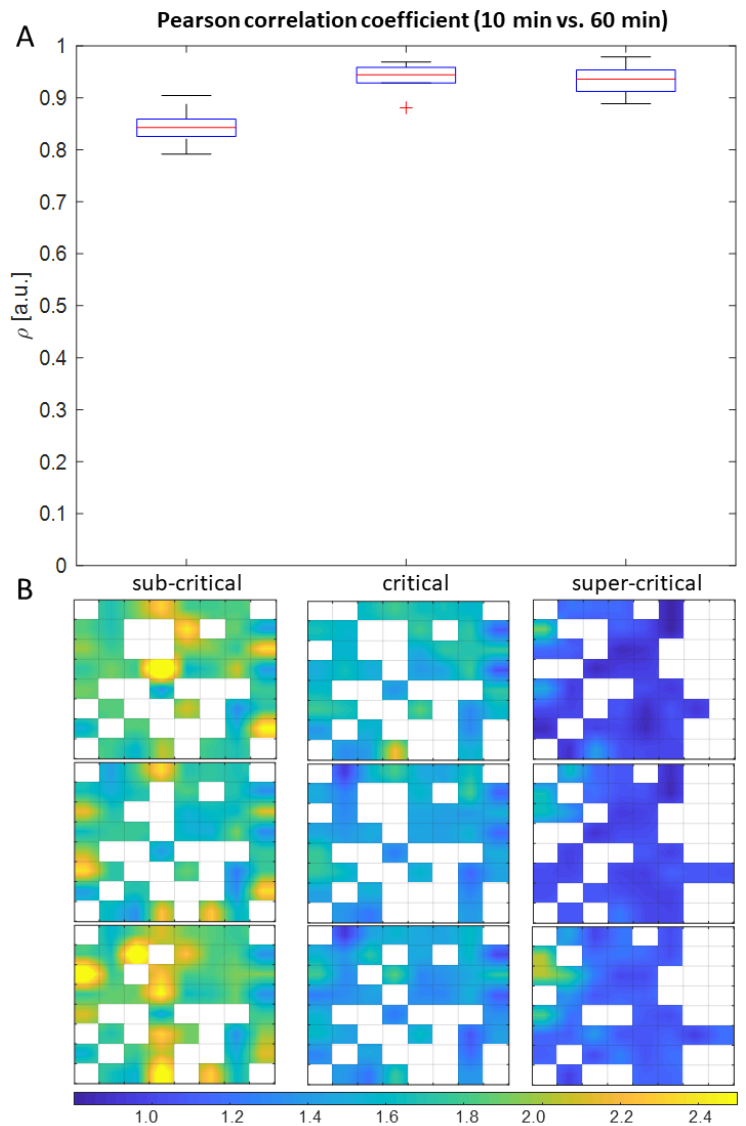
Figure A3. Same as Figure 4, but showing SampEn instead of ApEn and using a shorter duration of epochs (as SampEn is more stable that ApEn when considering short epochs). ( A ) Distributions of the Pearson correlation coefficients computed among each one of the 10 min sub-recordings constituting the full-length record (60 min) and the full length record itself. ( B ) Colour maps triplets (one for each culture) showing SampEn estimations on the three contiguous 20 min’